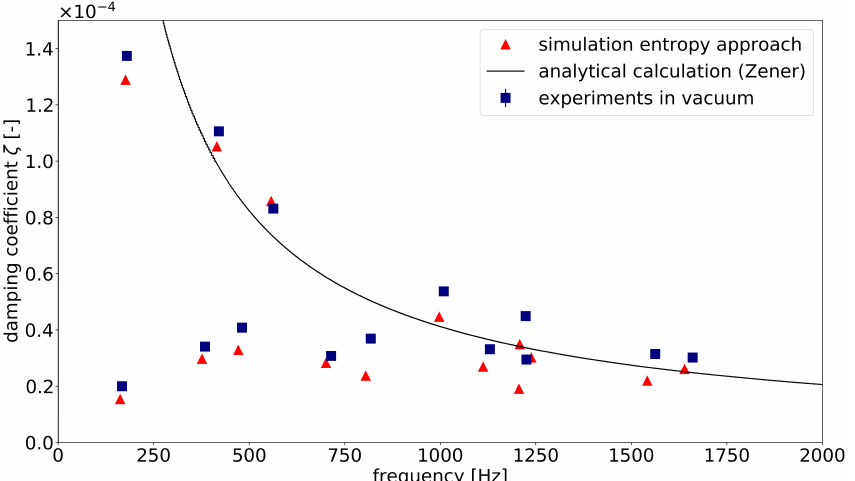
Figure 5. Comparison of experimental data, simulated damping coefficients and analytically calcu- lated values with equation according to Zener [15].